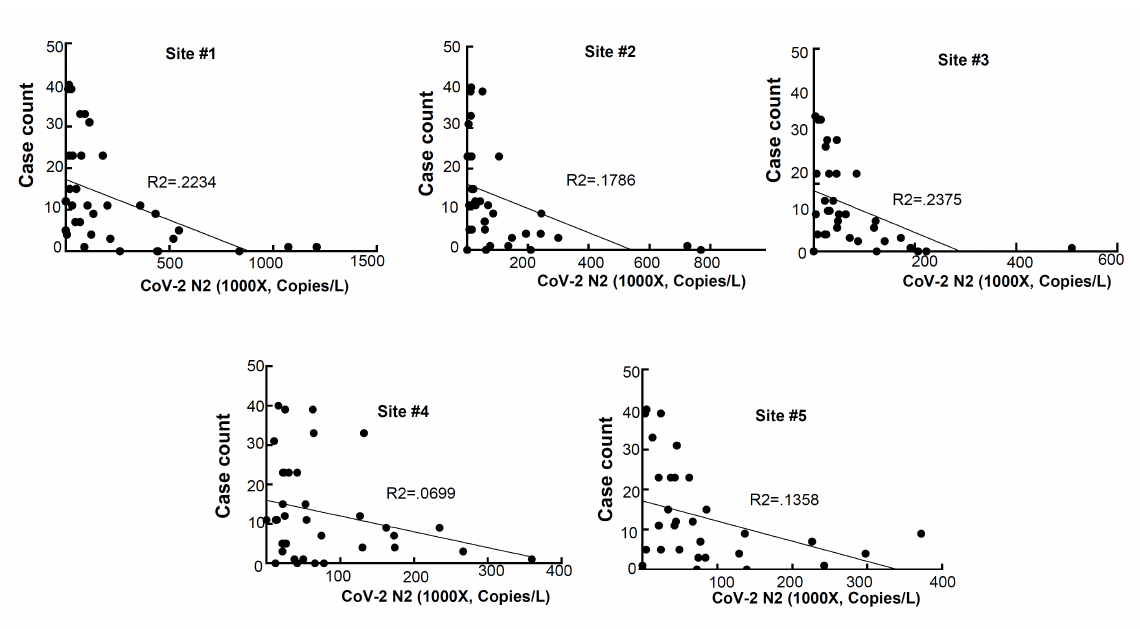
Figure 6. The correlative analyses of the SARS-CoV-2 gene copies with the COVID-19 case counts. The gene copies (per L) were plotted against the case numbers and the correlative analyses were